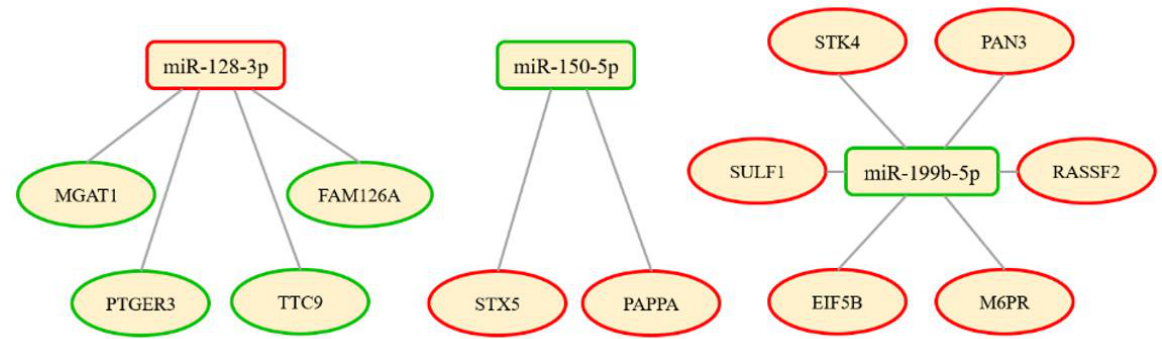
Figure 2. MiRNA and protein network link. The networks indicate predicted interactions between validated miRNAs and the significantly dysregulated proteins. Green = upregulation; red = downregulation.